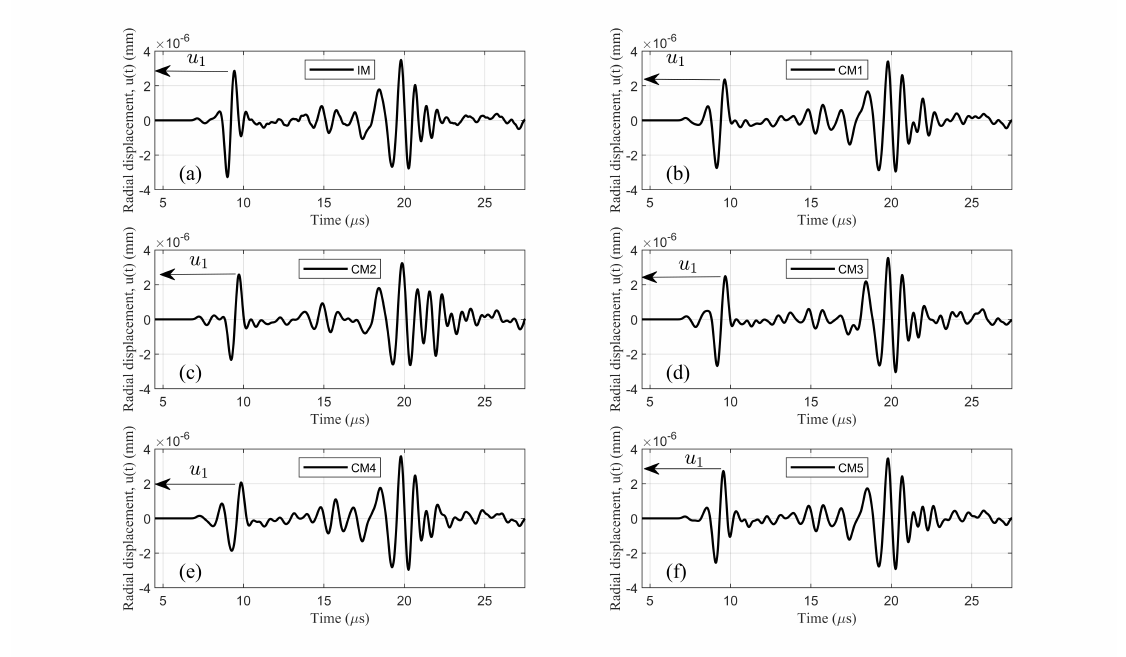
Figure 5. Time domain radial displacement u ( t ) in ( a ) intact model (IM); ( b ) corroded model 1 (CM1); ( c ) model CM2; ( d ) model CM3; ( e ) model CM4; and ( f ) model